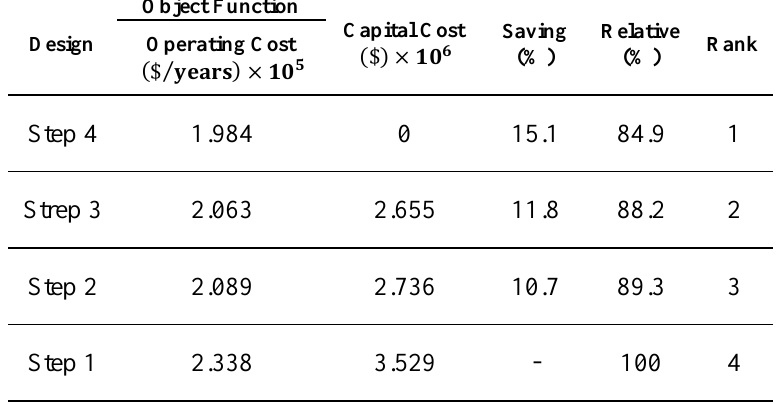
Table 14. Comparing the performance of designed column sequences with energy